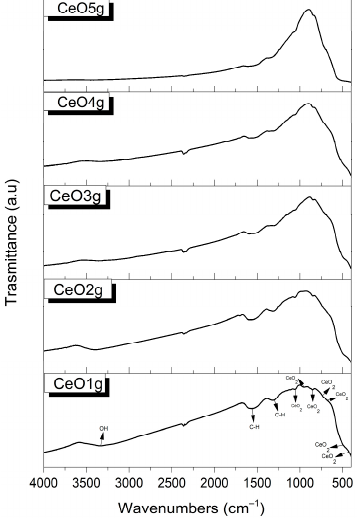
Figure 1. FTIR spectra of CeO 2 nanoparticles.